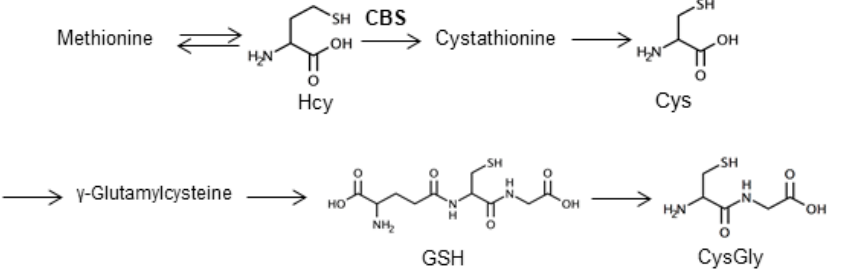
Figure 1. Metabolism pathway of homocysteine-related thiols and structures of target thiol compounds. Hcy, homocysteine; Cys, cysteine; GSH, glutathione, CysGly, cysteinylglycine, CBS, cystathionine β - synthase.